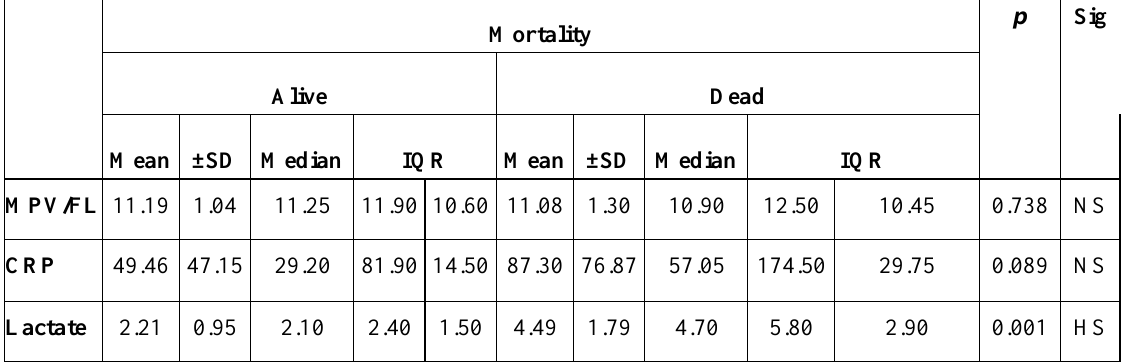
Table 3. Comparison between survived, and non-survived cases as regards laboratory